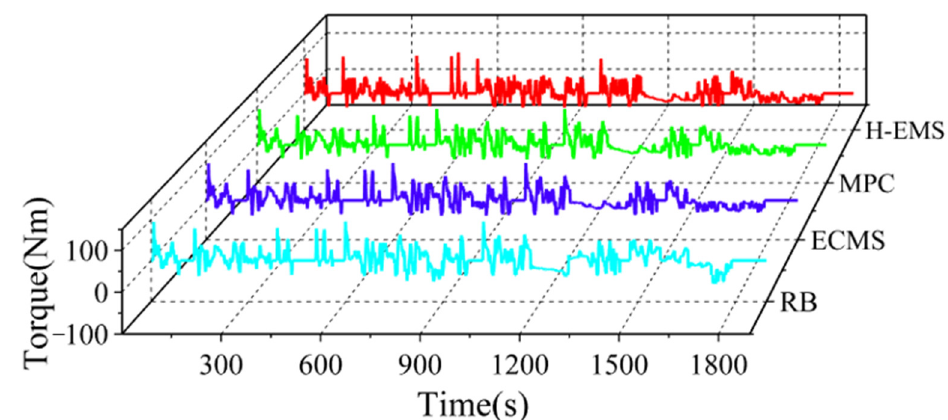
Figure 14. Front motor torque of energy management strategies.